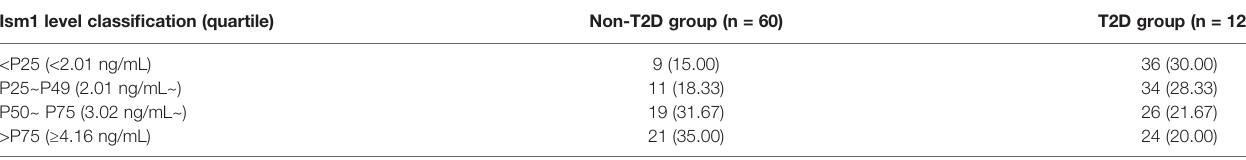
TABLE 2 | Distribution of Ism1 in the case and control groups.